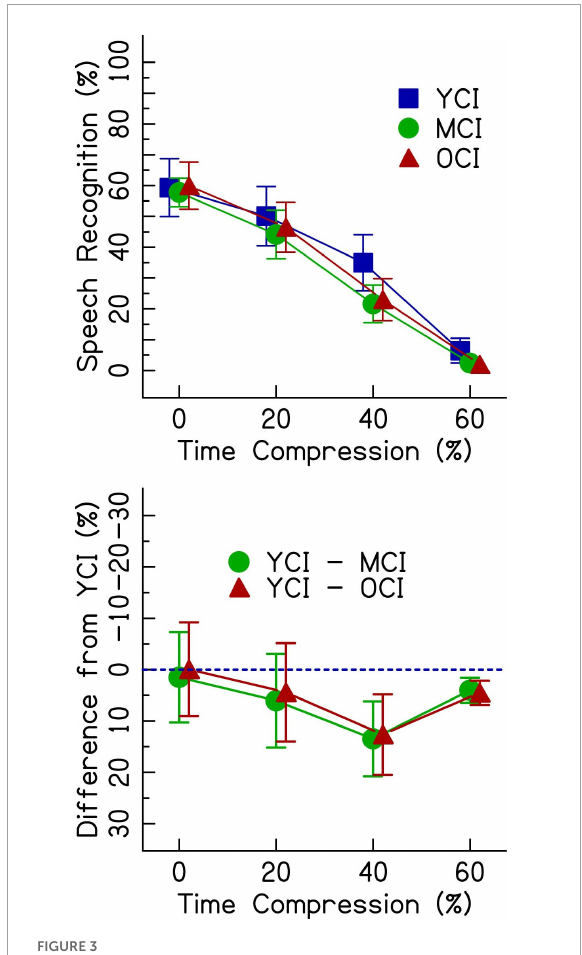
FIGURE3 The top panel shows speech recognition performance in percent correct for listeners with CIs in three age groups (younger, middle-aged, and older) listening to four rates of time compression (0, 20, 40, and 60%). Error bars show ± 1 standard error. The bottom panel shows the difference from the performance of the younger age group in percent. The dotted blue line represents the performance of the younger listeners. Data points below the line represent worse performance than the younger group. Error bars show ± 1 standard error and are based on 10,000 bootstrapped differences and the smallest group size of